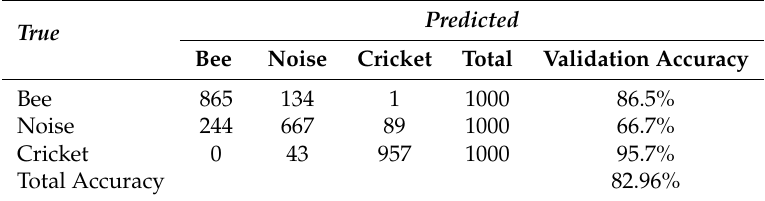
Table A12. Confusion matrix for ConvNet 1 with receptive field n = 80 on BUZZ2 on validation dataset.